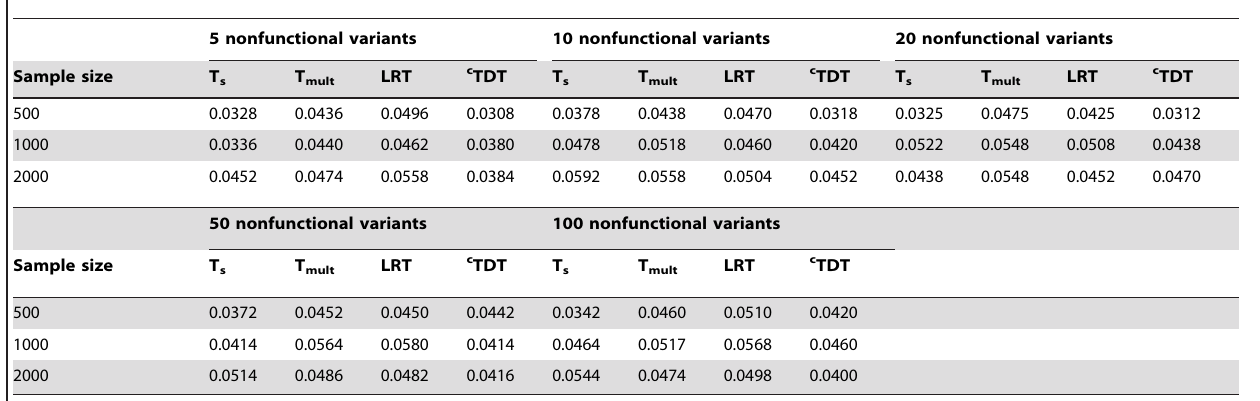
Table 1. Type I error rates of the tests when the true significance level is